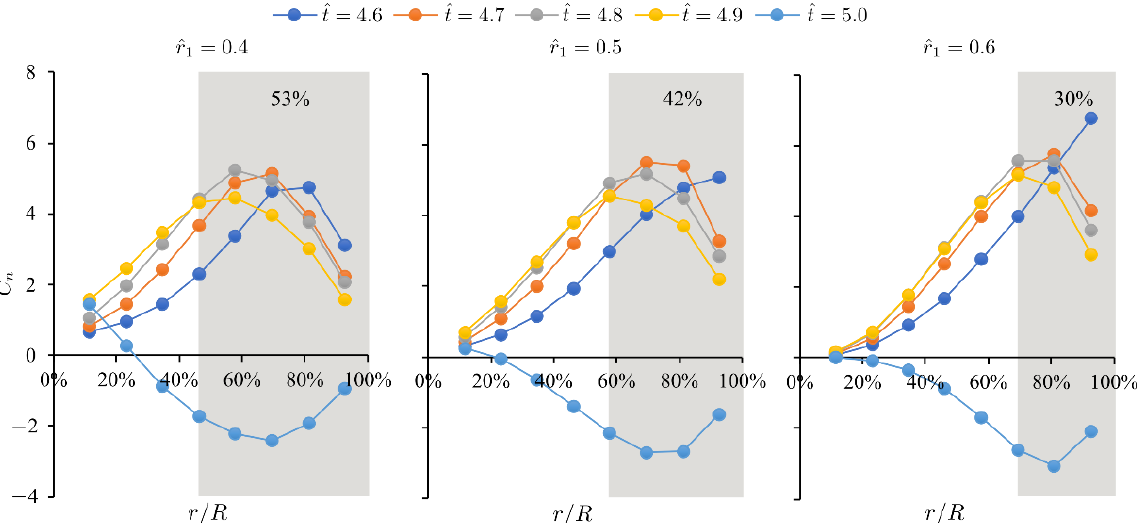
Figure 10. Normal force coefficient distribution along the wingspan for wings with different radial centroid locations. Grey areas represent regions where the normal force coefficient at ˆ t = 4.9 becomes lower than that at ˆ t = 4.8. Stroke amplitude is fixed to 160 ◦ and the aspect ratio is fixed to 4.5.